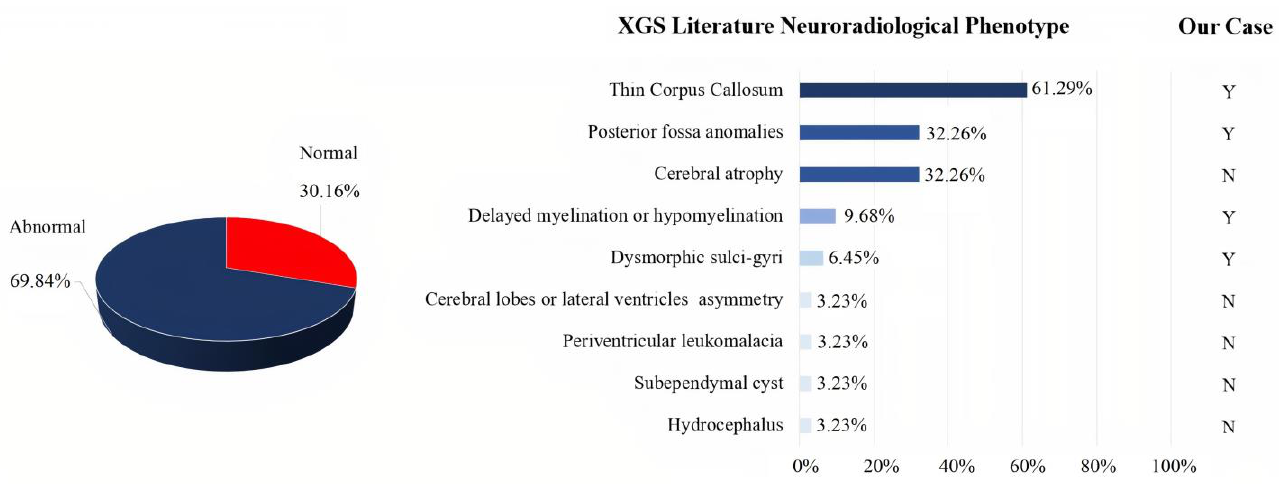
Figure 3. Bar graph showing XGS clinical phenotypes in 67 patients from the literature. Comparison between literature data (on the left), and our case (on the right). Y: yes. N: not present.